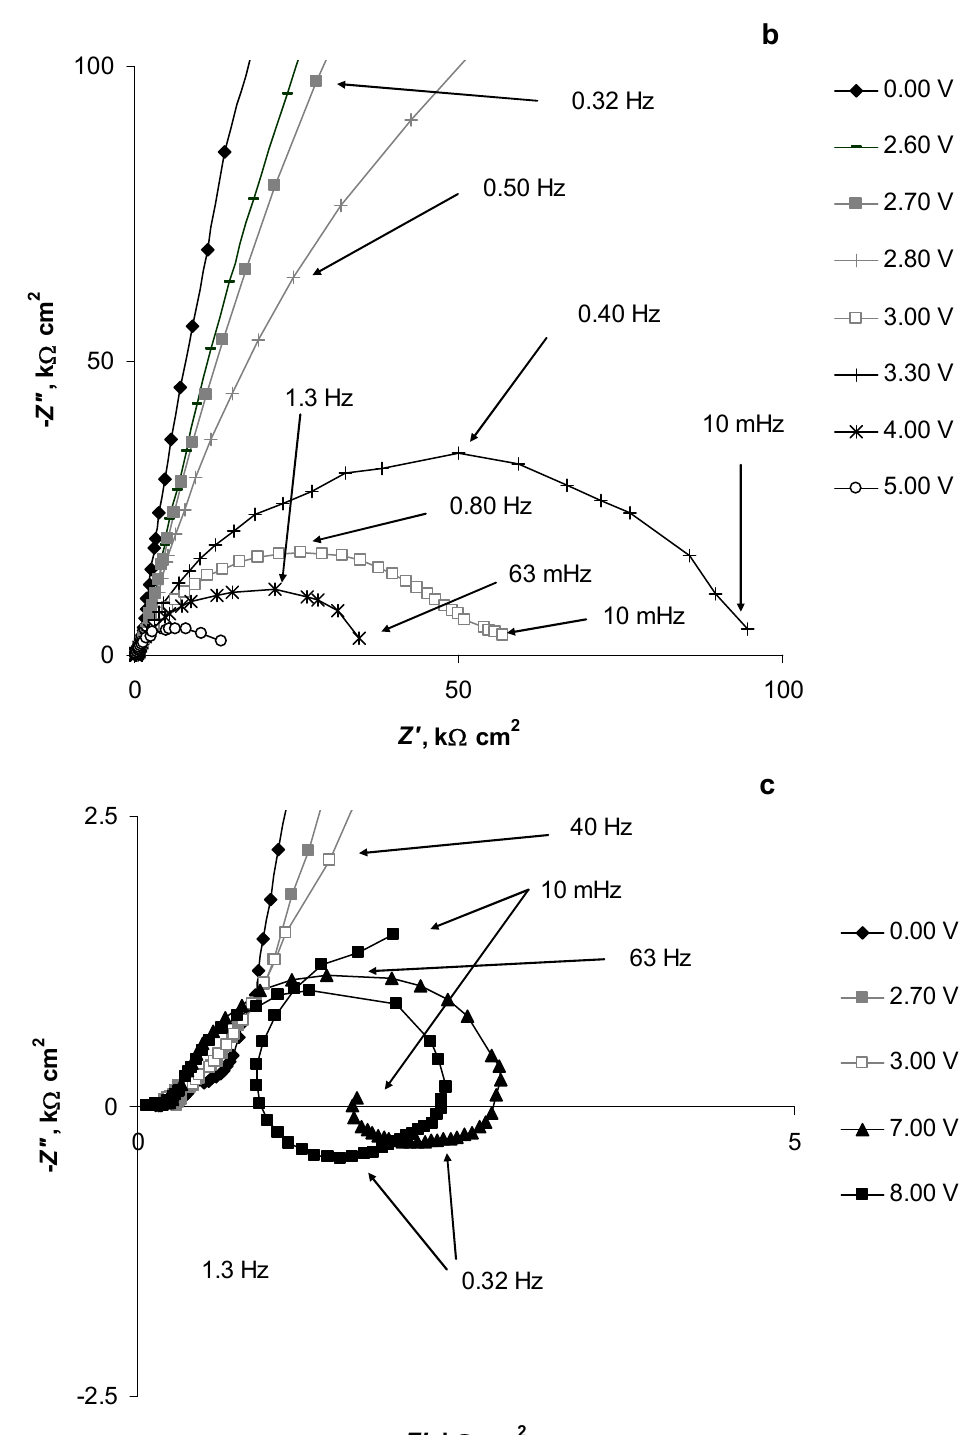
Figure 4. Nyquist plots, shown in various scales, for the N4111(TFSI)|Al/Al 2 O 3 system measured at fixed potentials noted in the figures ( a – c ).